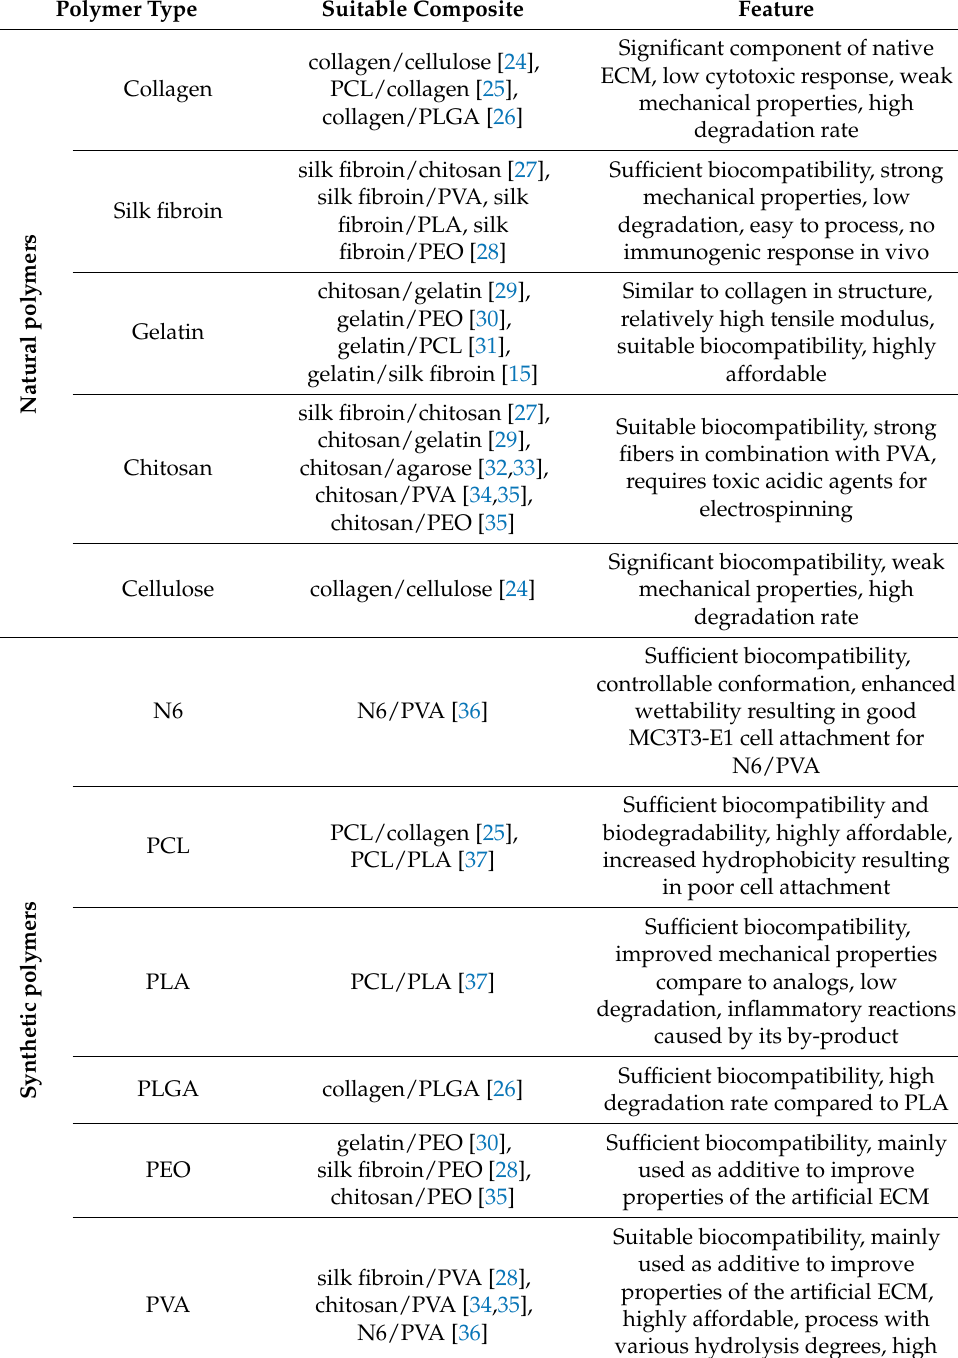
Table 1. Modern natural and synthetic polymers for